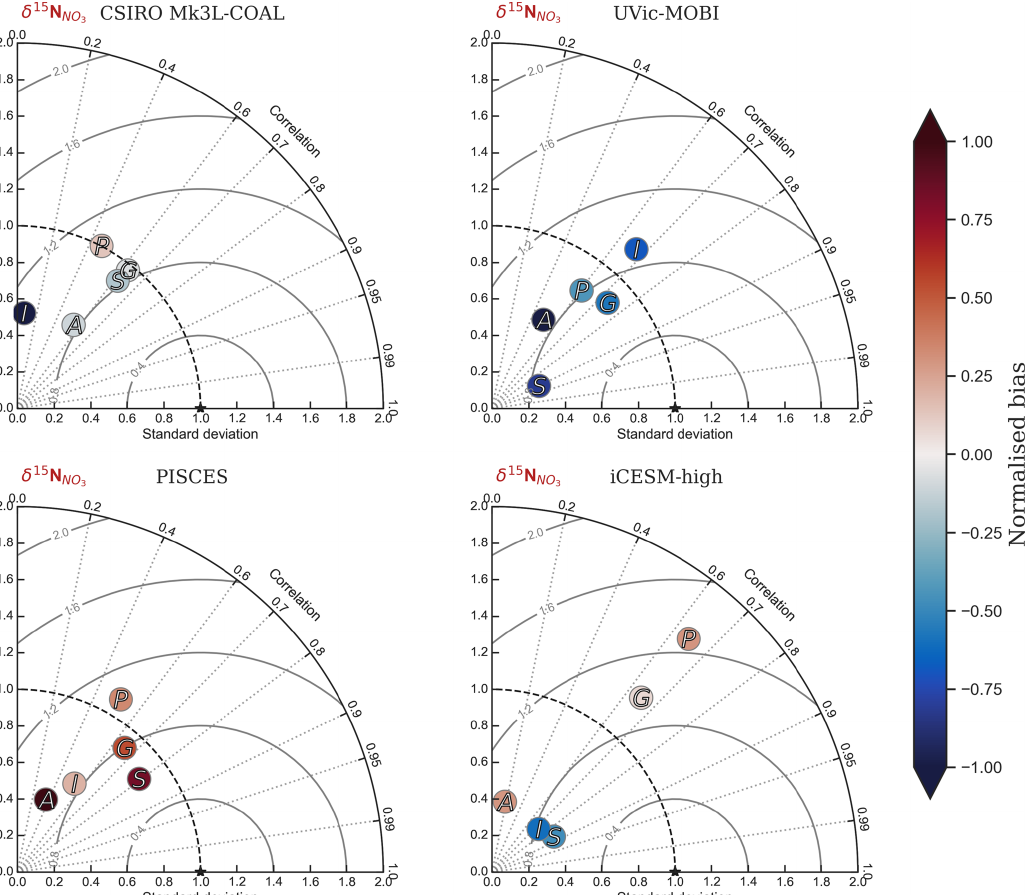
Figure 6. Global and regional fits between observations and simulated δ 15 N NO displayed as Taylor diagrams (Taylor, 2001). Shading of 3 the markers represent normalised bias. G indicates global; S indicates Southern Ocean (90–40 ◦ S); A indicates Atlantic (40 ◦ S–70 ◦ N); P indicates Pacific (40 ◦ S–70 ◦ N); I indicates Indian Ocean (40 ◦ S–70 ◦ N). The δ 15 N data (5330 measurements courtesy of the Sigman Lab, Princeton University) were binned into corresponding grid boxes and averaged for direct comparison, which reduced the data to 2532 points. More than one data point of δ 15 N may therefore contribute to each simulated